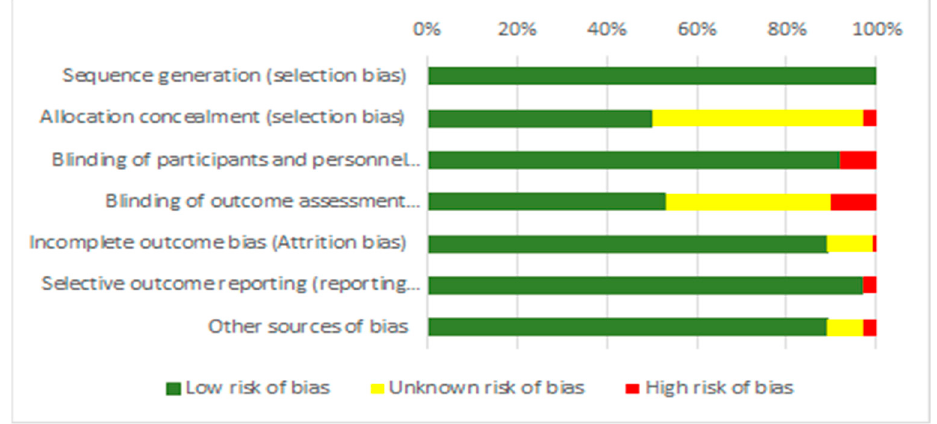
Figure 2. Risk of bias